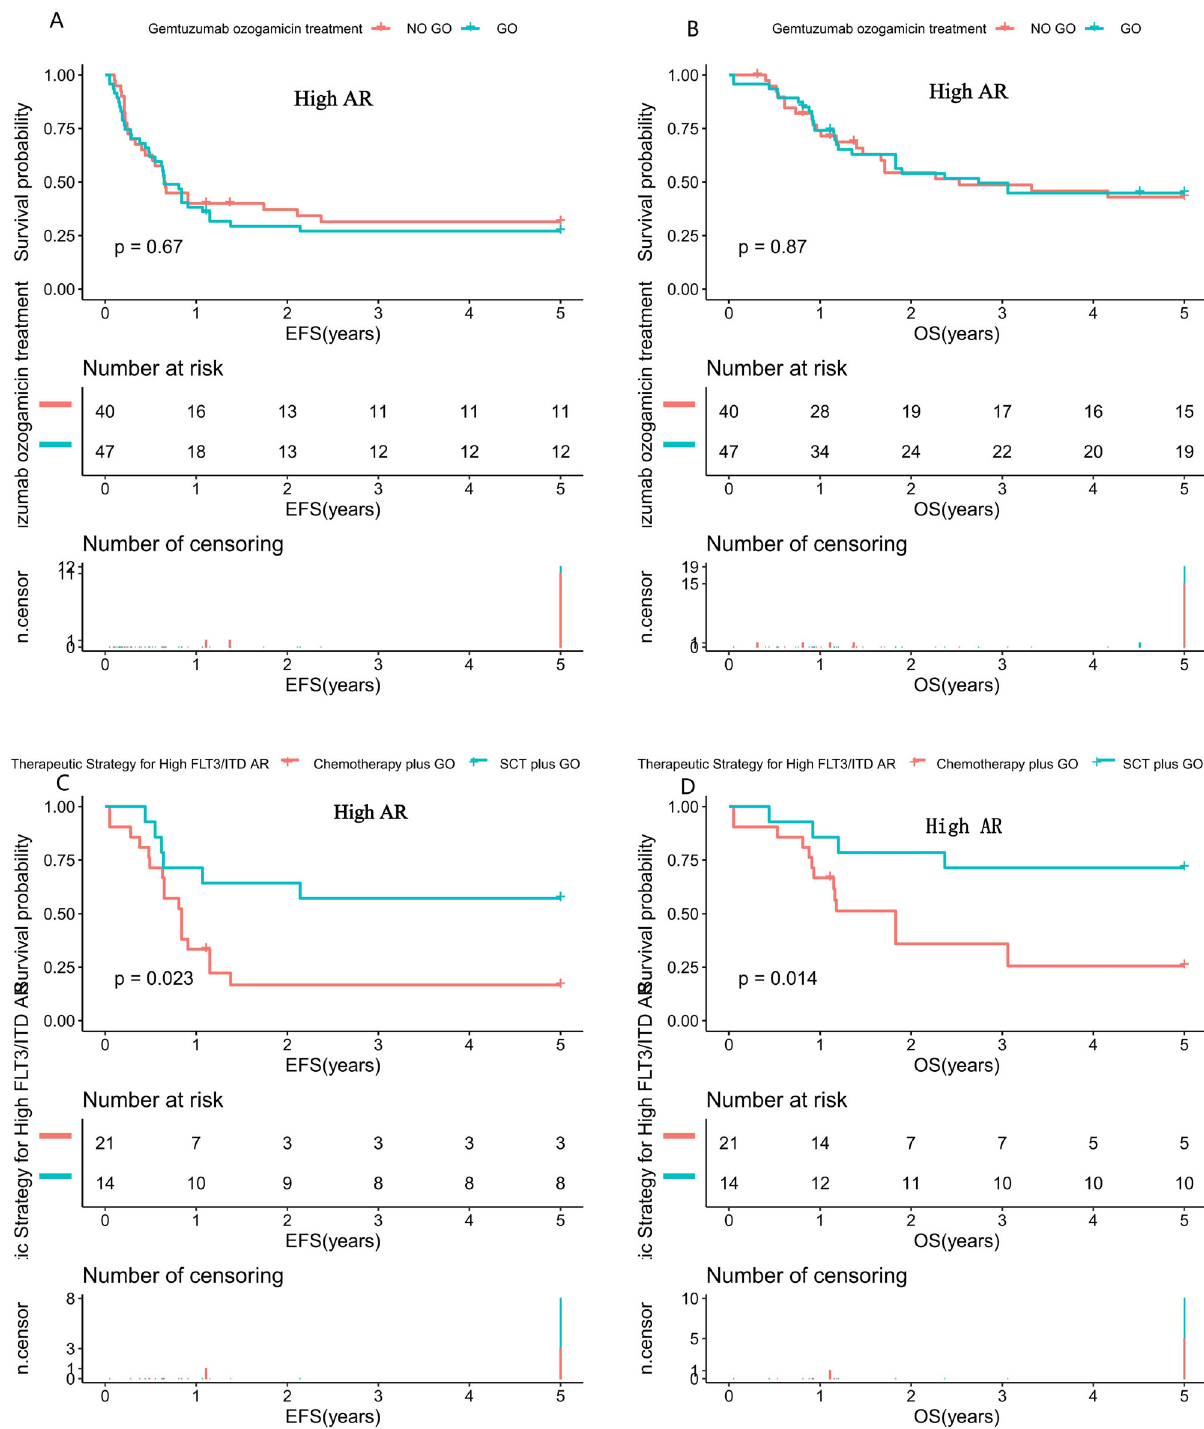
Fig. 6 Survival curves of patients with high FLT3/ITD AR AML patients according to different treatment strategy. A Probability of EFS for patients with and without GO treatment. B Probability of OS for patients with and without GO treatment. C Probability of EFS for patients with high FLT3/ITD AR according different treatment strategy. D Probability of OS for patients with high FLT3/ITD AR according to different treatment strategy. AML acute myeloid leukemia, SCT stem cell transplantation, GO Gemtuzumab Ozogamicin, AR allelic ratio, EFS event-free survival, OS overall survival. EFS and OS were evaluated by the Kaplan – Meier method and compared by log-rank test. Source data are provided as a Source Data fi Methods to December 2016, 2064 pediatric AML (non-M3) cases were enrolled in the Study participants . This study was approved by the ethics committee of TARGET database: 121 were excluded (secondary AML myeloid, n = 35; Down syndrome, n = 86), 86 were unable to be evaluated (loss of FLT3/ITD infor- National Cancer Institute ’ s Of fi ce of Cancer Genomics. We obtained demo- mation, n = 4; insuf fi cient data on therapy, n = 82), and fi nally, 1857 patients graphic, clinical characteristics, and laboratory data of AML in children under with childhood AML were enrolled in our research. The results published here the age of 18 from the TARGET dataset (April 28, 2021). From September 1996